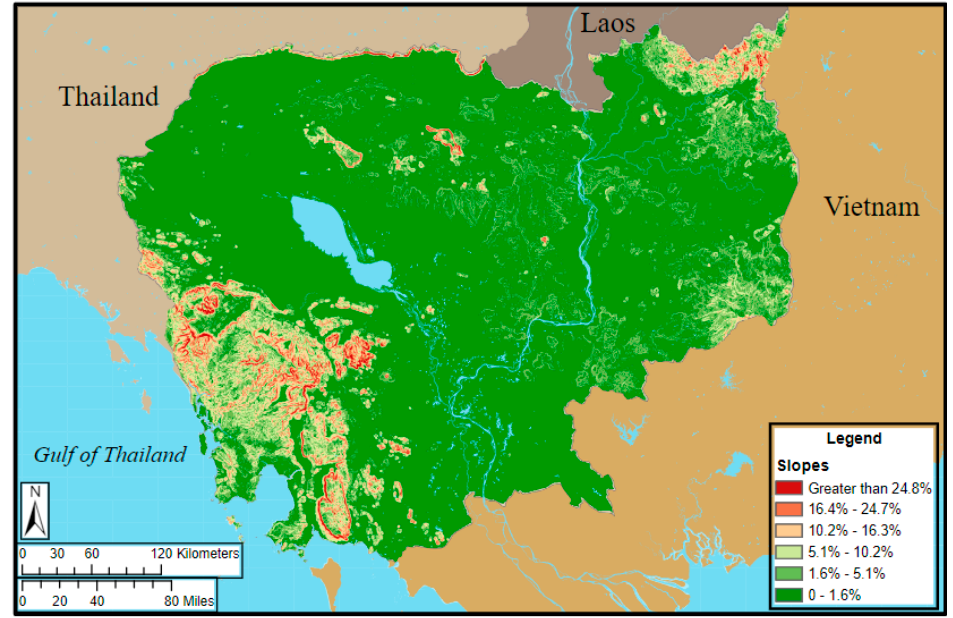
Figure 4. Calculated slope map of Cambodia. Adapted from Open Development Cambodia’s [33] georelief